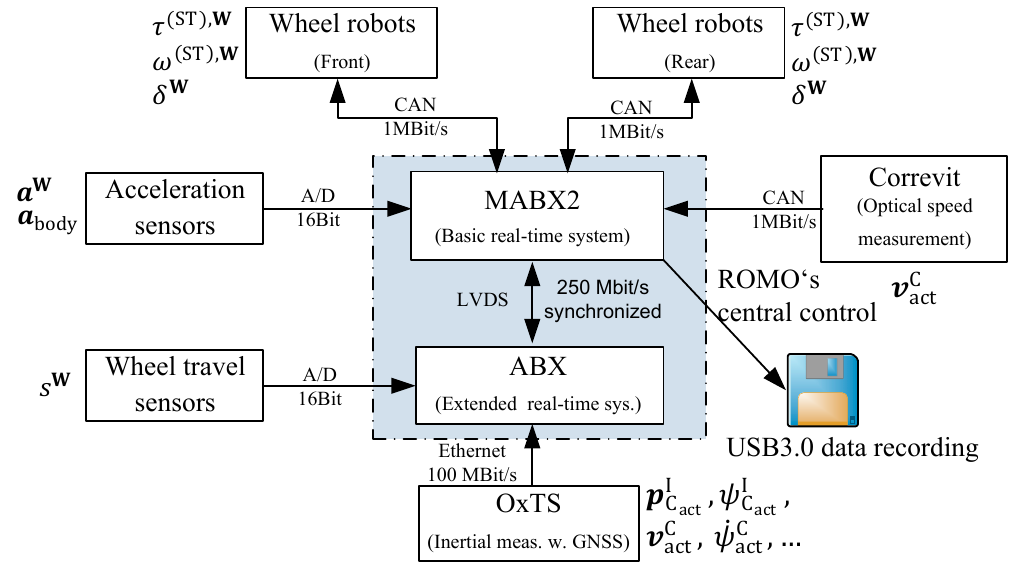
Figure 15. ROboMObil’s vehicle dynamics sensors and actuators architecture. OxTS—inertial measurement unit; ABX—AutoBox (rapid prototyping real-time controller); MABX2—MicroAutoBox II (embedded rapid prototyping real-time controller).